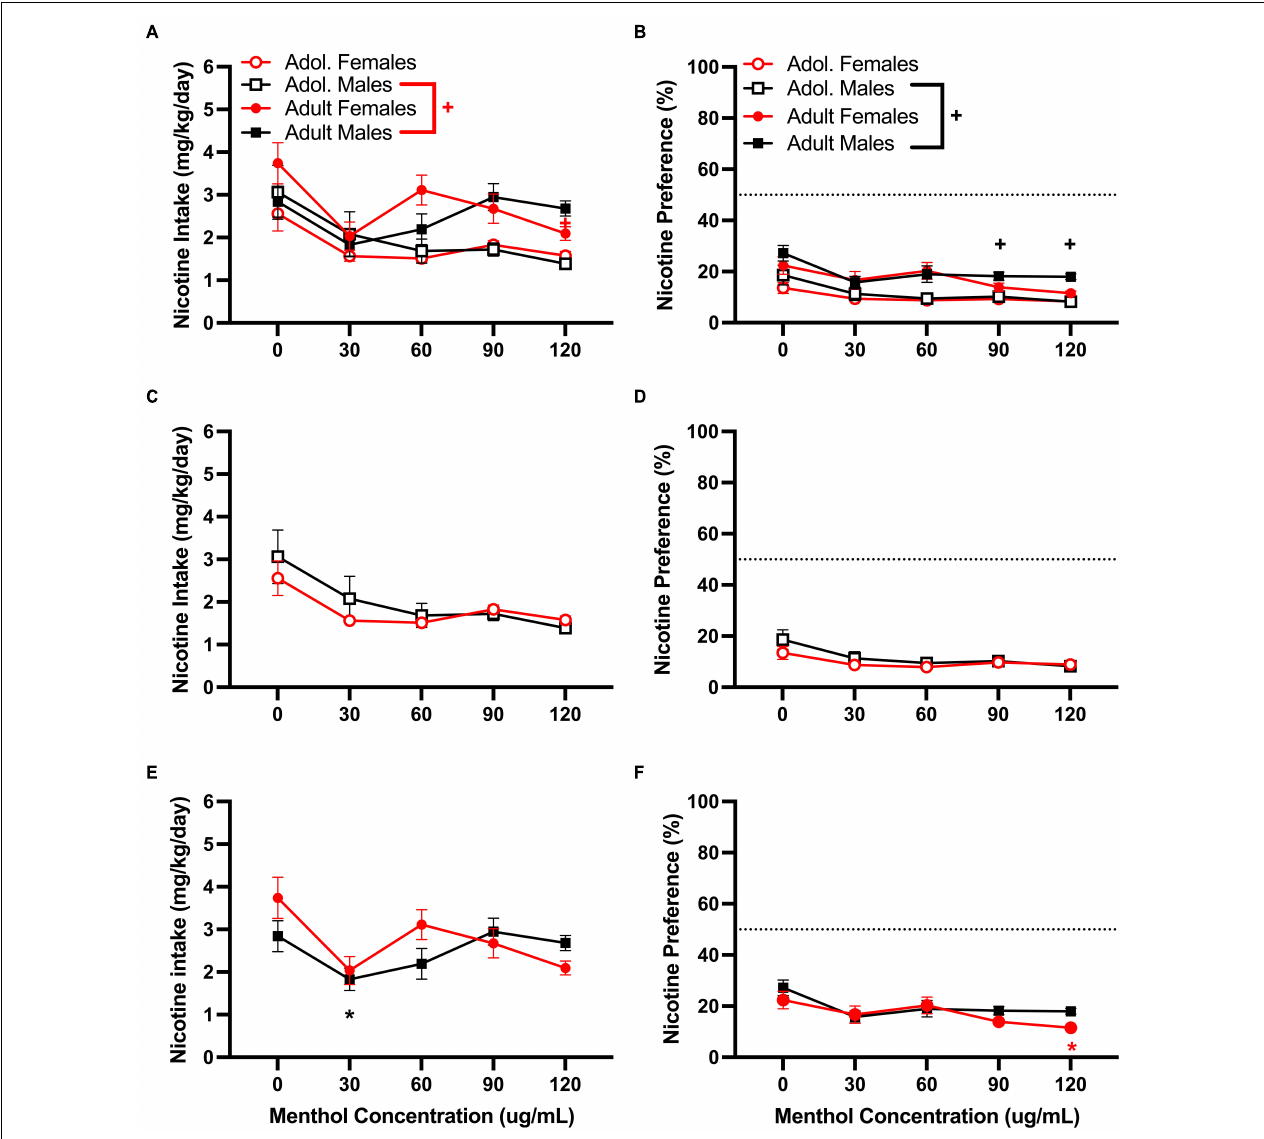
FIGURE 3 | Effects of menthol on oral nicotine (60 µ g/mL) consumption in adult and adolescent male and female DBA/2J mice. Mice were given a choice of DI water or menthol + nicotine [nicotine (60 µ g/mL) + menthol 0–120 µ g/mL] in a within-subject manner in the two-bottle choice paradigm. Intake is calculated as mg of drug per kilogram (mg/kg) of body weight and preference as the volume of drug solution consumed as a percentage of the total fluid consumed. (A,C,E) Average nicotine intake (mg/kg/day) and (B,D,F) nicotine preference (%) are shown. Data are presented as the mean ± SEM of 10-15 mice/sex/age. Results are based on a RM three-way ANOVA with age, sex, and menthol concentration as factors. + P < 0.05 vs. adults. * P < 0.05 vs. 0 µ g/mL. # P < 0.05 vs. males.